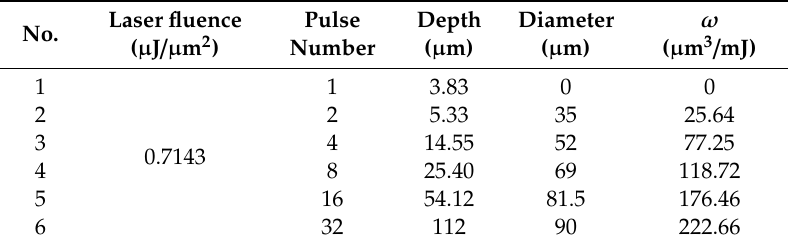
Table 3. Ablation experiment data at 50 °C substrate temperature.